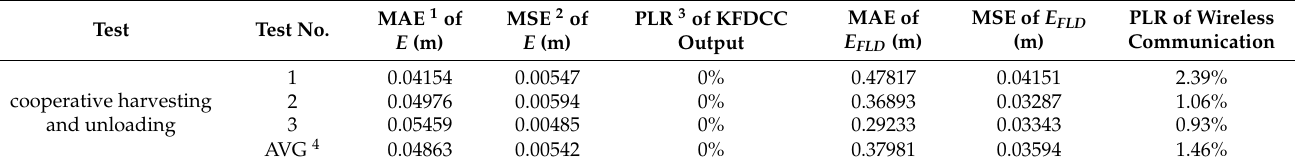
Table 5. Test results of field harvesting